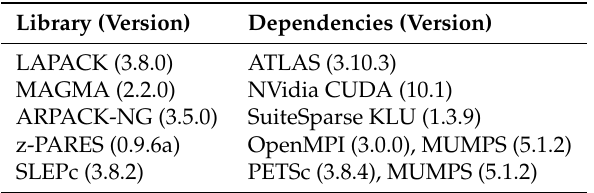
Table 5. Versions and dependencies of open-source libraries for non-symmetric eigenvalue